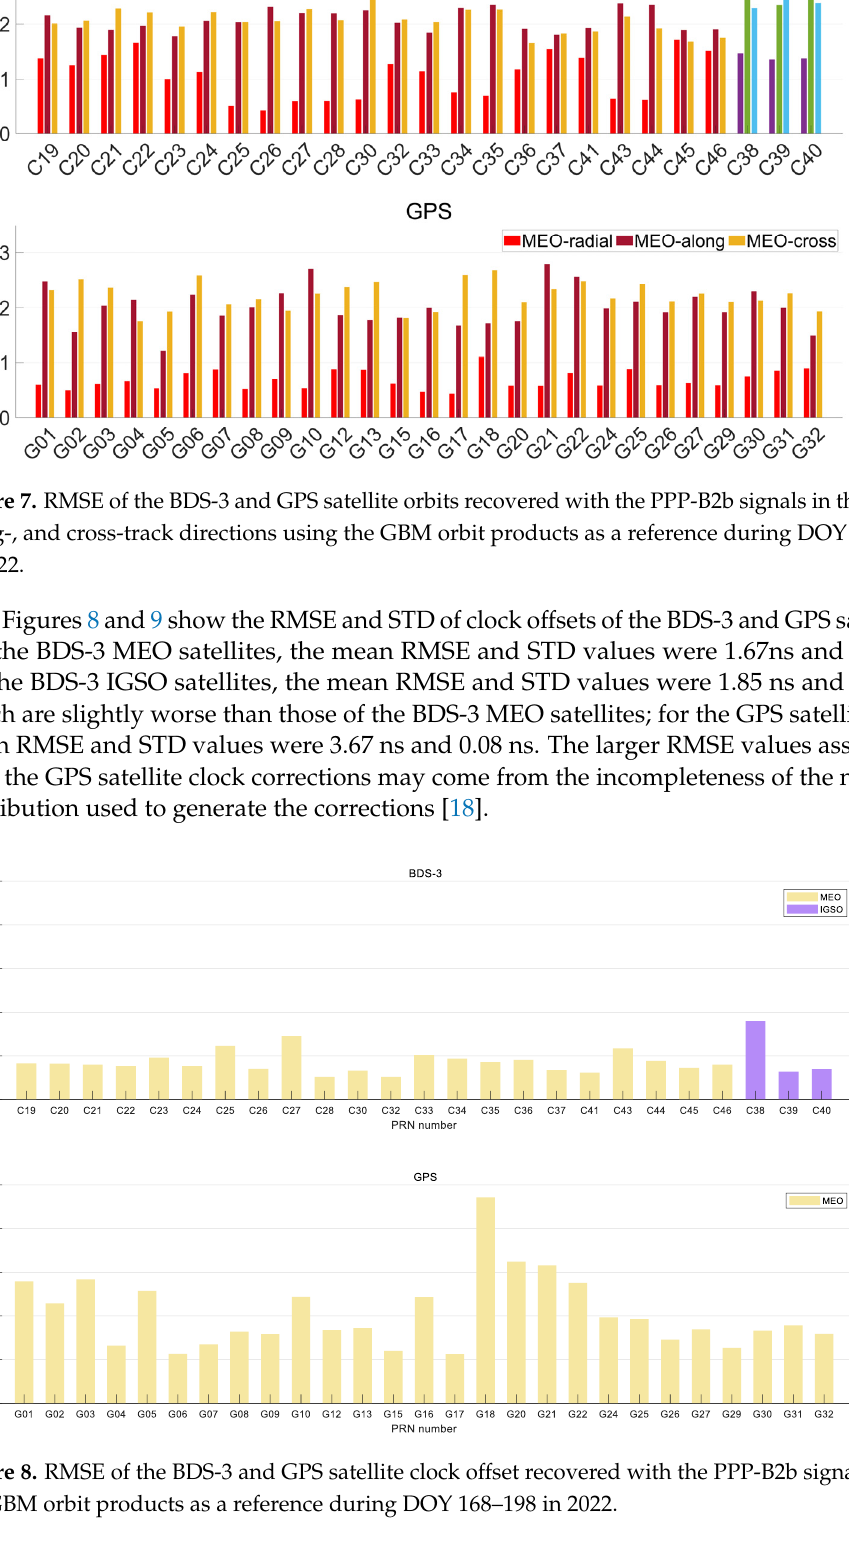
Figure 9. STD of the BDS-3 and GPS satellite clock offset recovered with the PPP-B2b signals using the GBM orbit products as a reference during DOY 168 – 198 in 2022. 3.2.2. Accuracy of the PPP-B2b Extension Corrections In this study, the degradation of the PPP-B2b corrections within one hour was inves- tigated using the data on DOY 192 in 2022. In our experiment, we assume that the track to the PPP-B2b signal was lost after we received the pair of clock and orbit corrections at a broadcast epoch on DOY 192. Then, the clock and orbit corrections at this epoch were used as the corrections for the following hour. The differences between these extended corrections and the actual PPP-B2b corrections were then calculated. Then, we moved to the next broadcast epoch and extended the PPP-B2b corrections for the epoch during the following hour, and we calculated the differences between these extended corrections and the actual PPP-B2b corrections. This procedure was repeated from the first epoch to the end epoch, and we thus obtained several time series with a time length of 1 h and an